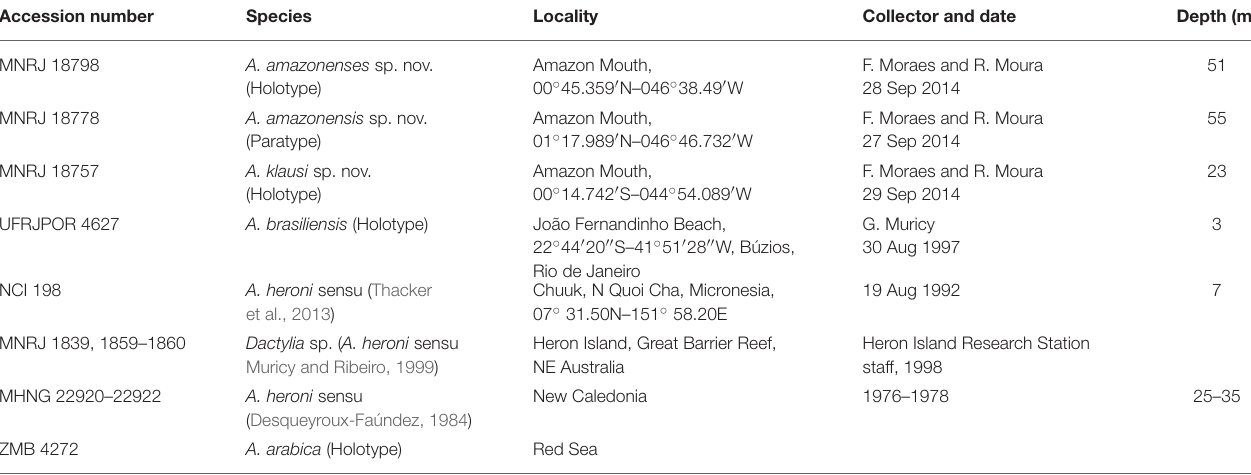
TABLE 1 | List of the studied specimens and comparative materials used to assess the phylogenetic relationships of Amazon Arenosclera